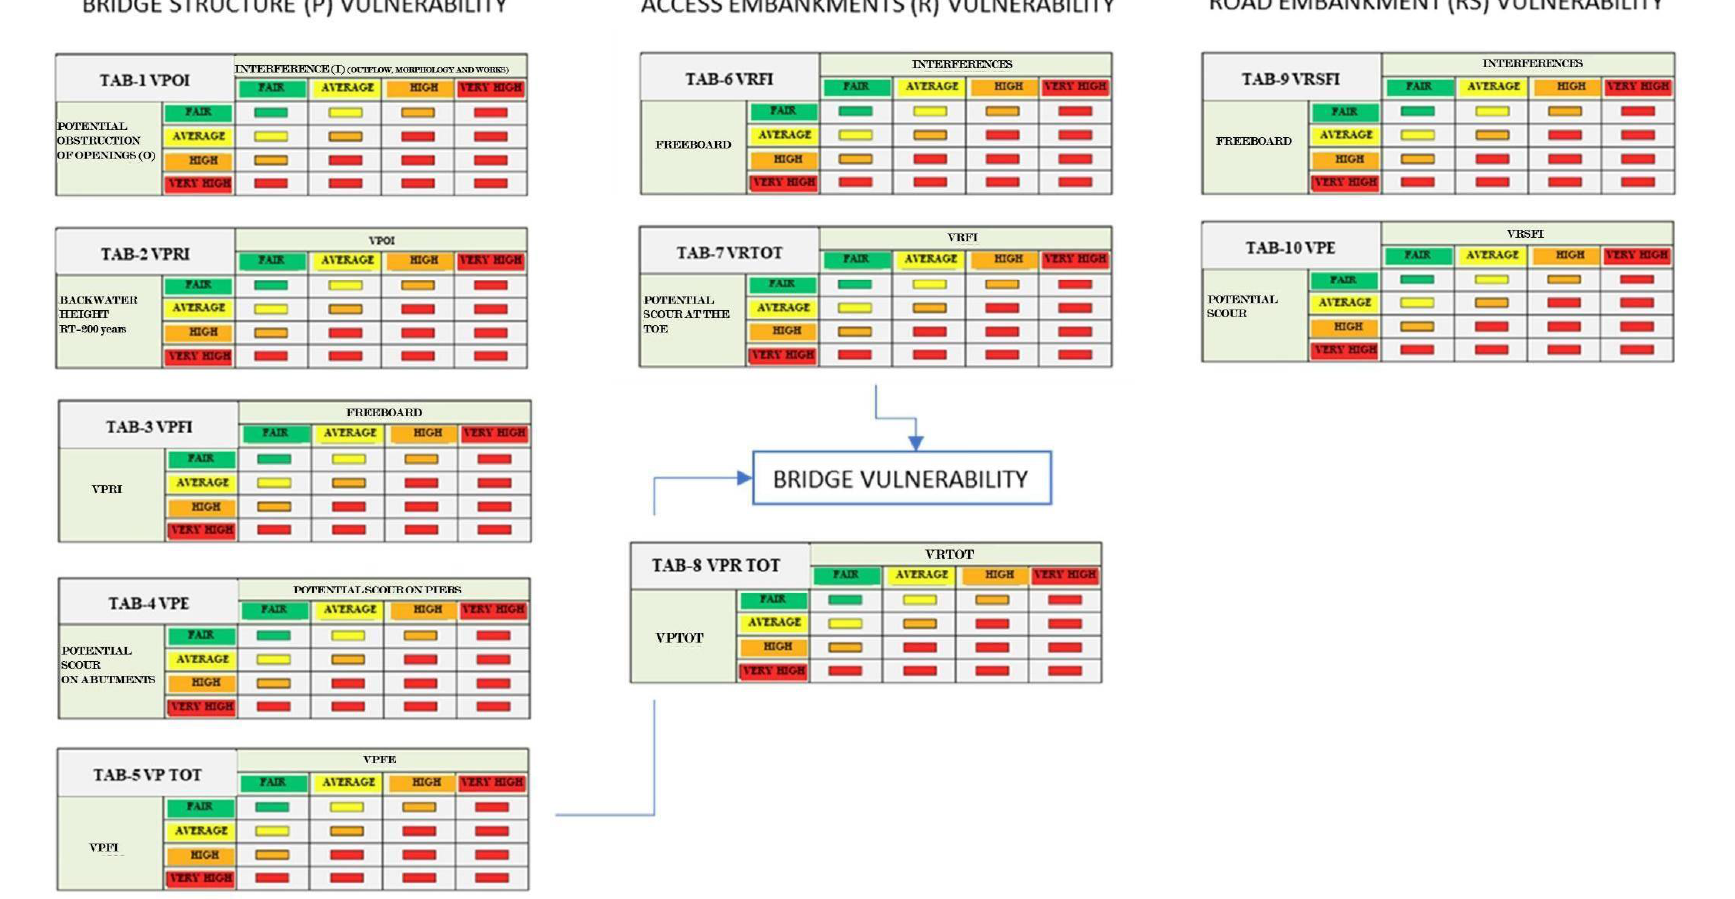
Figure 5. Methodological path for the estimation of the bridge total vulnerability.